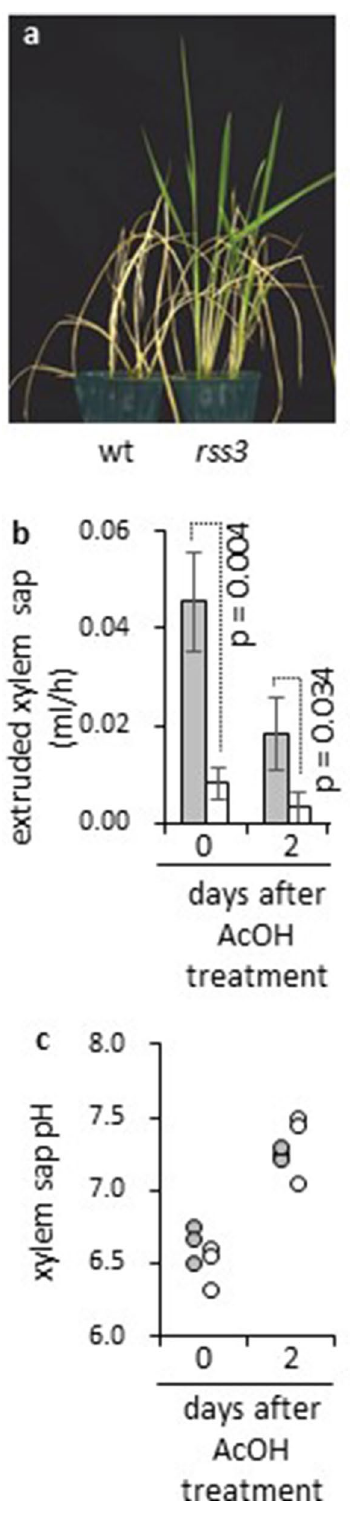
Figure 4. A mutant deficient in repressive regulation of JA signaling in root tip shows drought avoidance. ( a ) Wild-type and rss3 were grown for 16 days, then subjected to drought conditions for 4 days followed by cultivation for 10 days under well-watered conditions. ( b ) Flow rate of xylem sap in wild-type (gray) and rss3 (white) was examined before and after treatment with 30 mM acetic acid for 2 days. n = 3; error bars, standard deviation. Statistical significance was examined by Student’s t-test. ( c ) Xylem sap pH of wild-type (gray) and rss3 (white) was examined before and after treatment with 30 mM acetic acid for 2 days ( n =